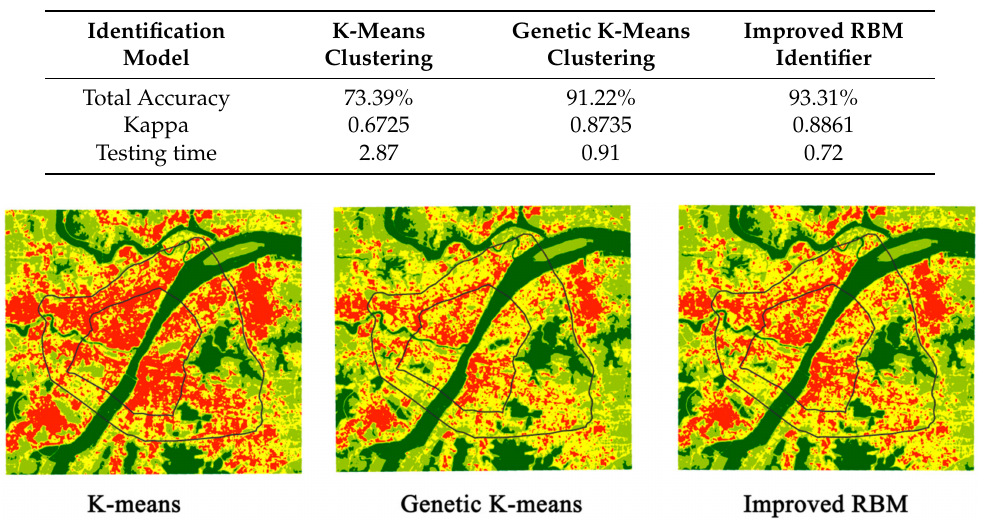
Table 5. Identification accuracy comparison of different methods.